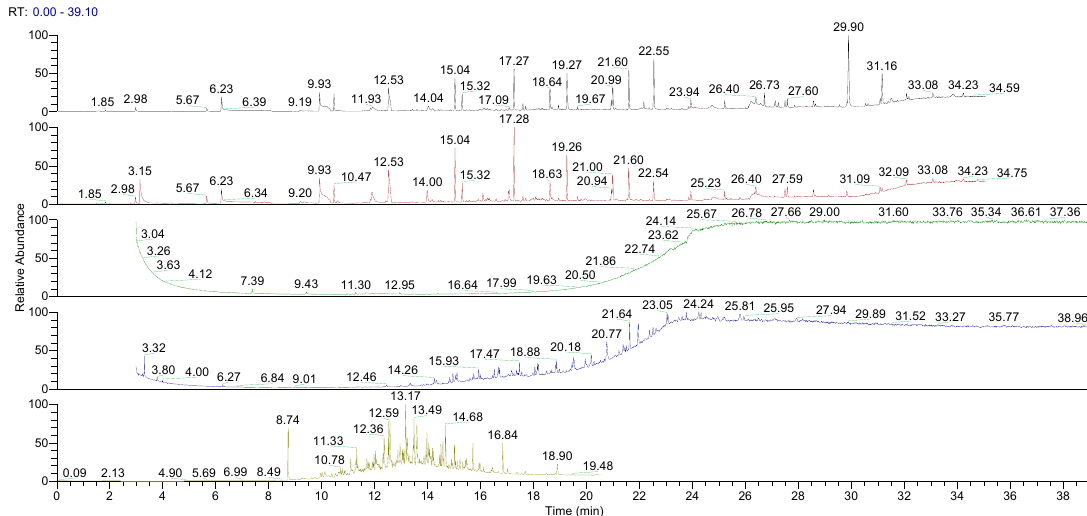
Figure 2. Chromatograms obtained by gas chromatography-mass spectrometry (GC/MS) of all the extraction methods on untreated linear low-density polyethylene (LLDPE) single dose containers. From the top: Sonication pH 2, sonication pH 10, Sealed Vessel, Soxhlet, and HS SPME (Head Space Solid Phase microextraction).